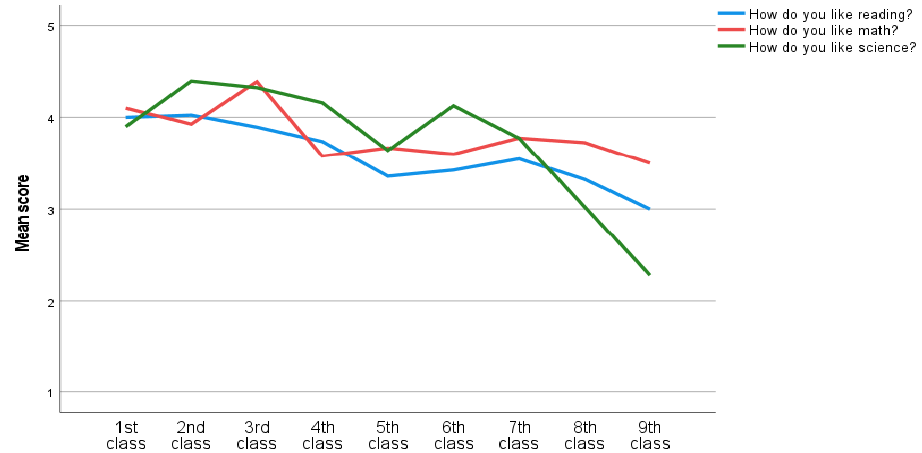
Figure 2. How do you like reading, math and